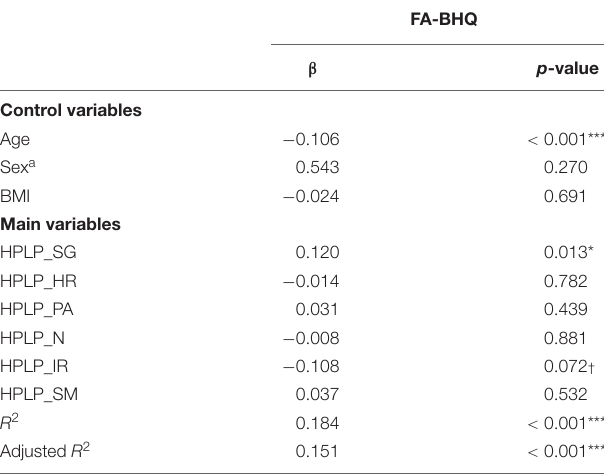
TABLE 5 | Multiple regression analysis of HPLP factors on